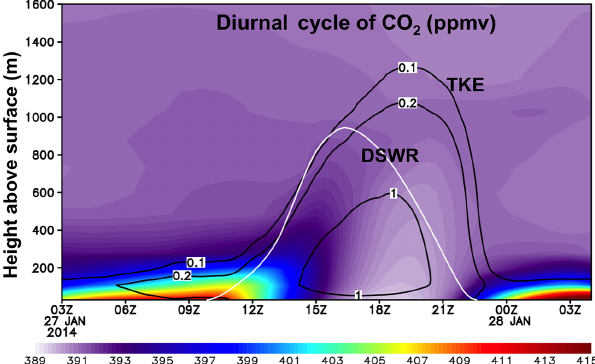
Figure 15. The diurnal cycle of the CO 2 mixing ratio (ppmv, shaded colors), the turbulent kinetic energy (TKE, m 2 s − 2 , black contours), and the downwelling shortwave radiation at the surface (DSWR, Wm − 2 , in white line and using the same scale as the height above the surface on the left) as simulated by BRAMS with the JULES surface scheme in the low troposphere. All quantities are area aver- aged over a portion of the Amazon Basin with tropical forest as the dominant vegetation type, and correspond to an example for 27 Jan- uary